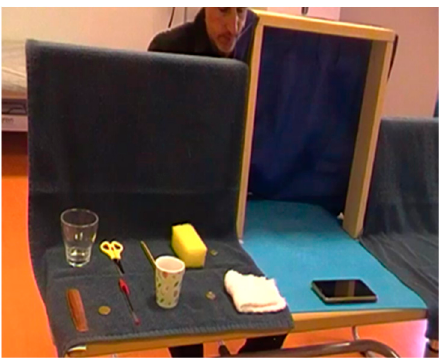
Figure 1. Frame and standardization of the stereognosis subscale.